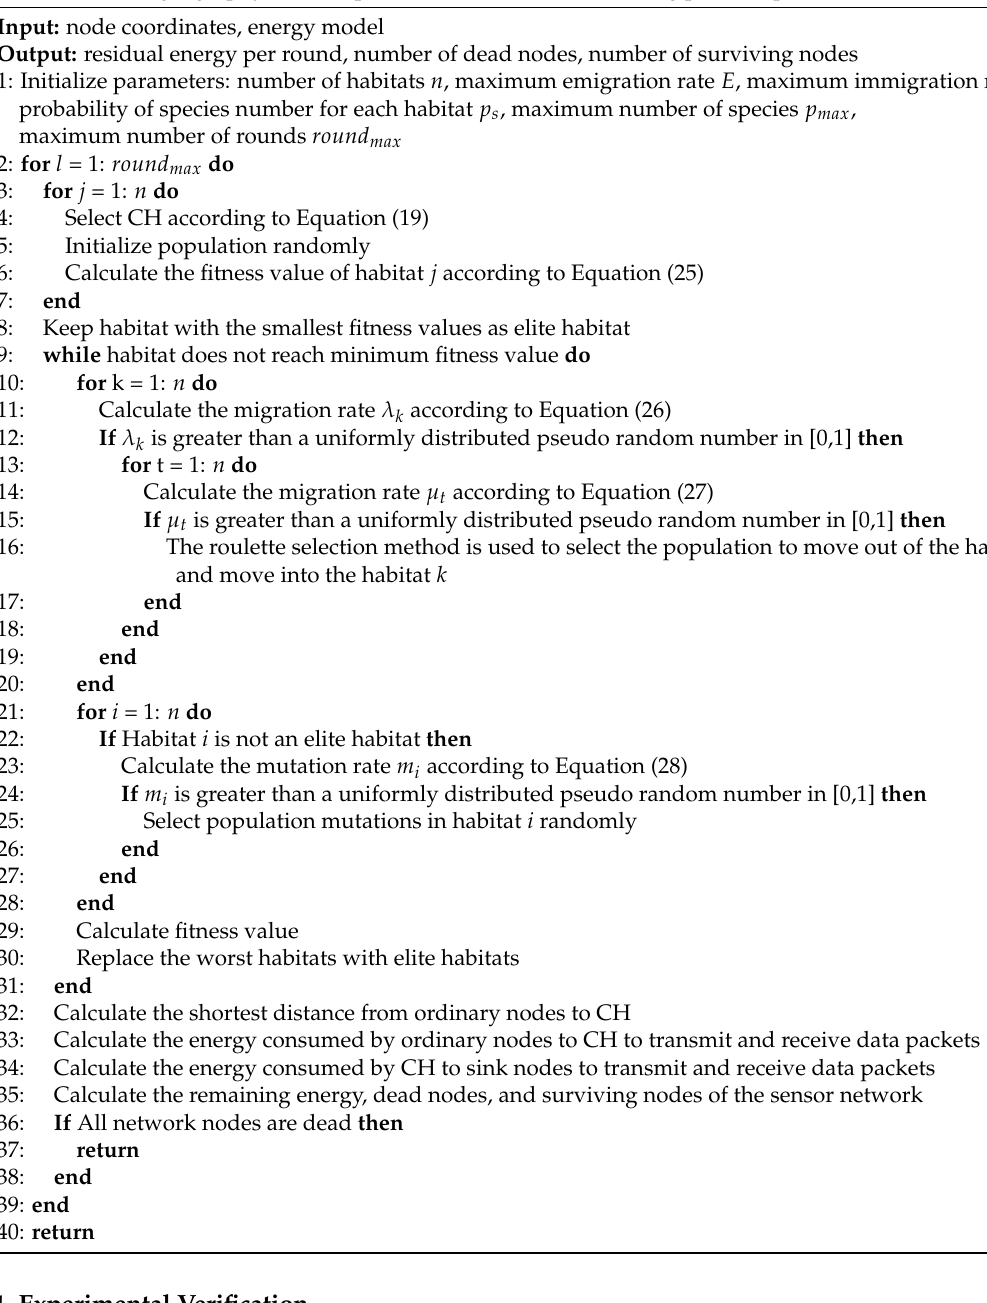
Algorithm 2 Biogeography-Based Optimization (BBO)-based routing protocol